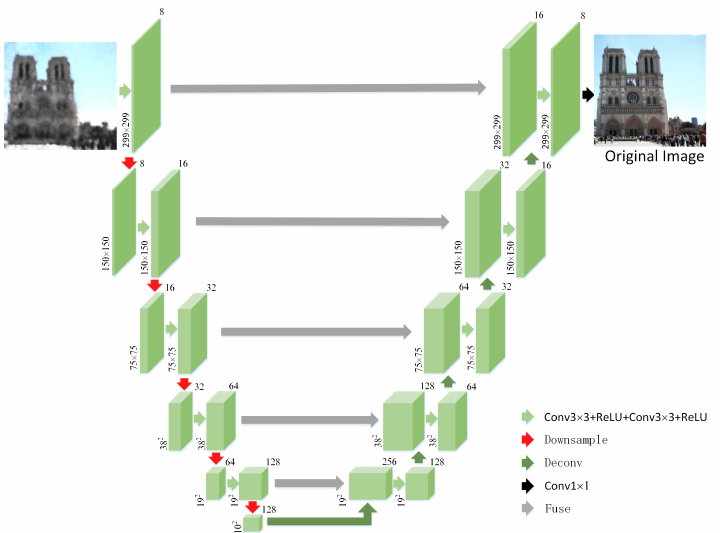
Figure 5. The structure of the network DIP 2